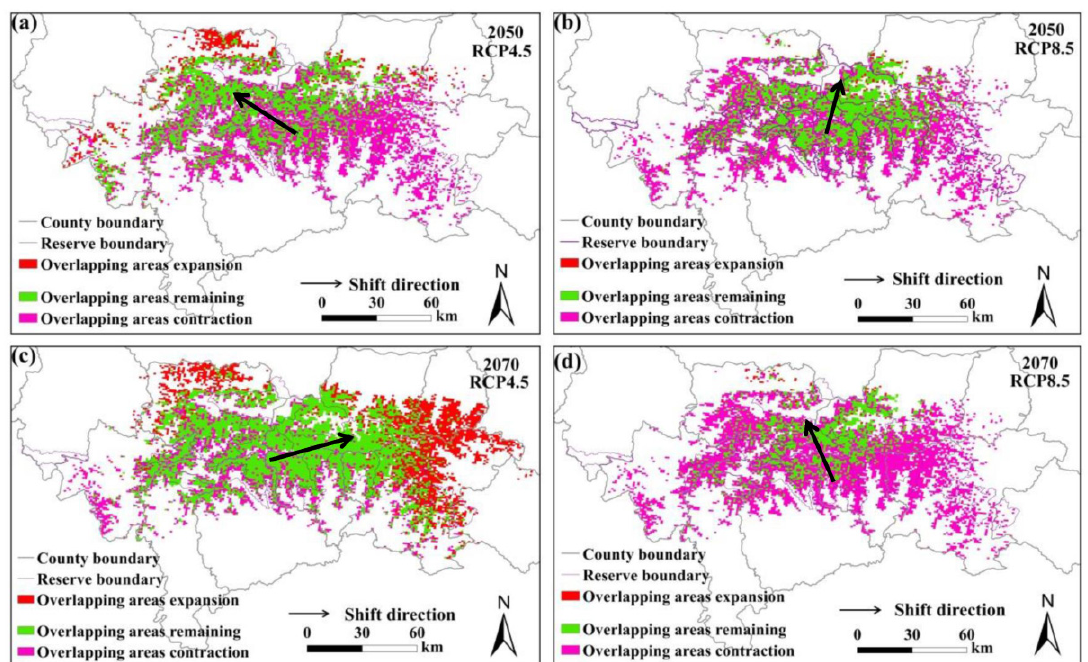
Figure 2. Overlapping suitable habitat for giant pandas and black bears under different climate change scenarios. ( a , b ) represent the changes under the RCP4.5 and RCP8.5 scenarios in 2050s, respectively; ( c , d ) represent the changes under the RCP4.5 and RCP8.5 scenarios in 2070s, respectively.